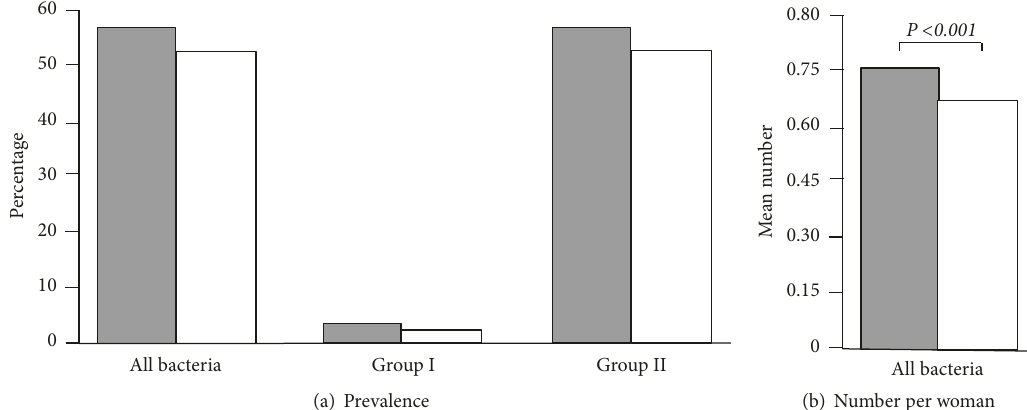
Figure 4: Percentages of detection (a) and mean number of genital microorganisms detection (b) by multiplex real-time PCR Allplex (cid:2) STI Essential Assay (Seegene) of genital bacteria, including common curable sexually transmitted infections (group I) and commensal mycoplasmas (group II) in paired genital secretions obtained by gold standard clinician-collected endocervical swab (white) and by self- collection using the V-Veil-Up Gyn Collection Device (V-Veil-Up Pharma Ltd.) (grey) among 251 study women living in N’Djamena, Chad. P -values of the comparison between the percentages of detection by the two collection methods using the Mac Nemar’s test for paired data were not significant for all comparisons. P -value of the comparison between the mean numbers of detected genital bacteria by the two collection methods using the Wilcoxon signed-rank test is indicated in